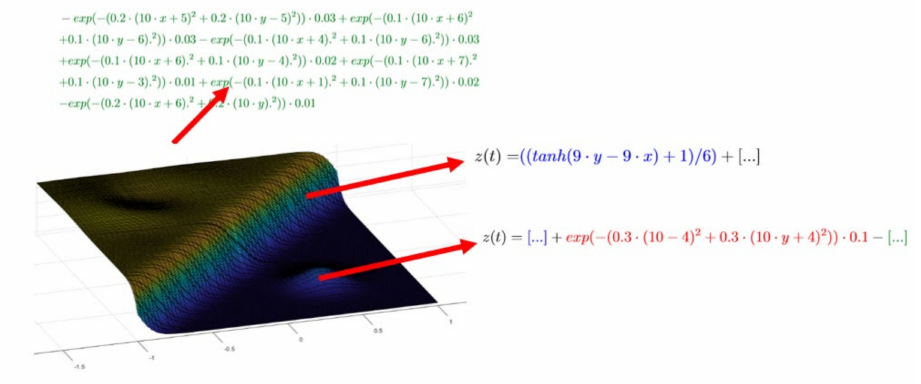
Figure 6. Mathematicalsurfaceservingasareferenceforthe3DprintingaftertheT-splinesurfaceapproximation.